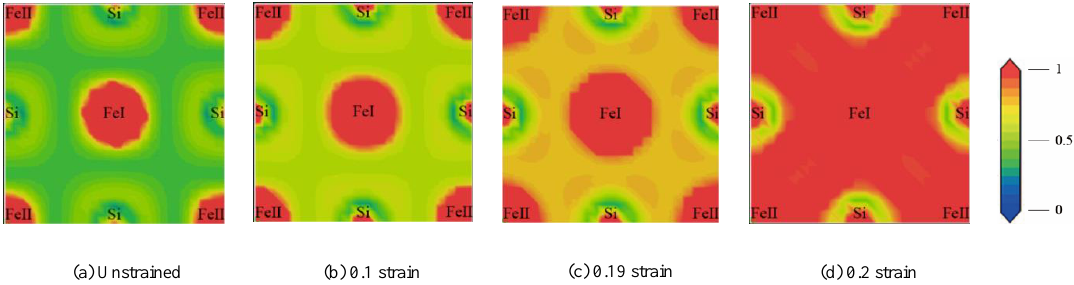
Figure 11. Valence electron density distribution in the (200) atomic planes of DO3 under triaxial compressive strain. ( a ) unstrained, ( b ) 0.1 strain, ( c ) 0.19 strain and ( d ) 0.2 strain.